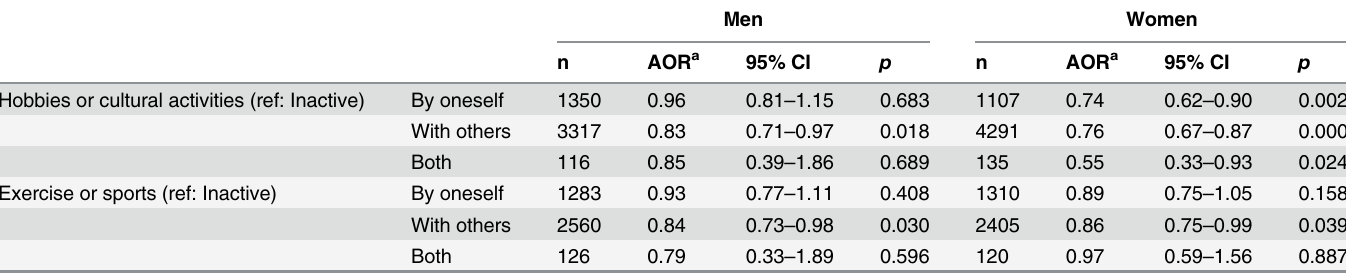
Table 3. Multiple logistic regression analyses for the relations between the way of participation and mental health status at the follow-up